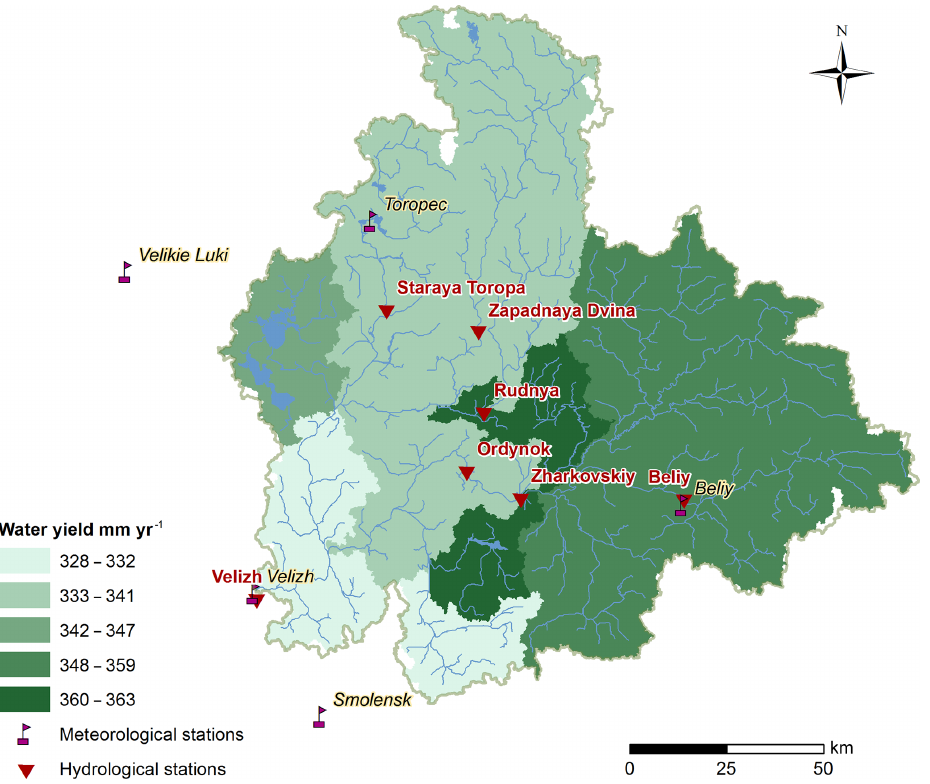
Figure 1. Annual water yield distribution for Russian part of WDRB (SWAT based – mean for